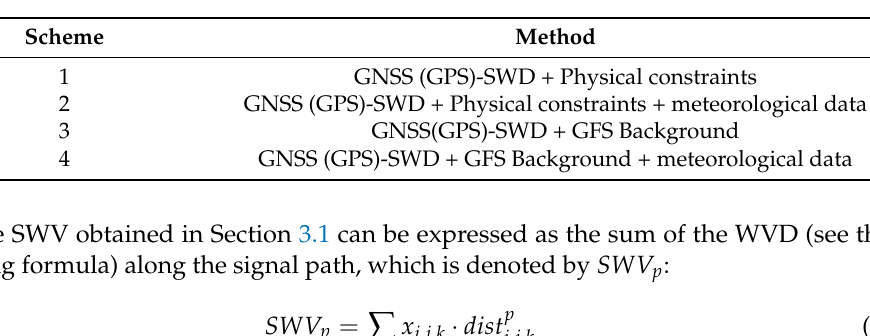
Table 2. Four schemes adopted for the construction of the tomographic